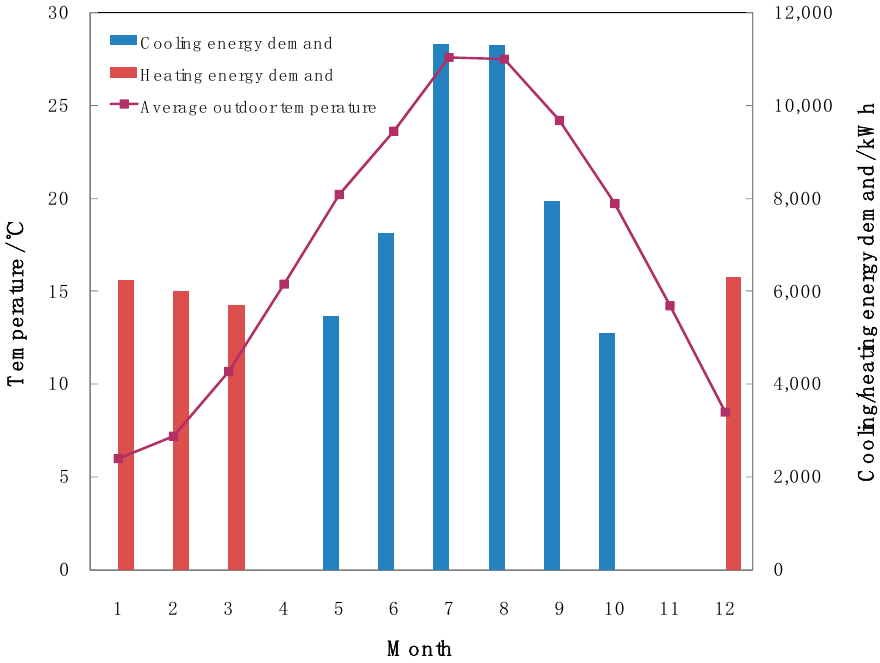
Figure 8. The monthly average outdoor temperature and building cooling and heating energy demand in 2018.